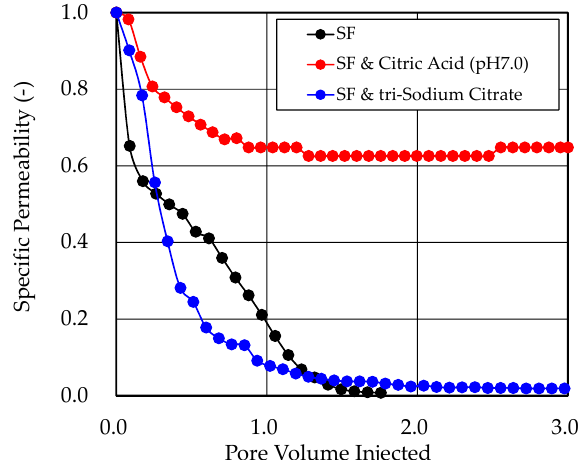
Figure 6. Temporal change in the specific permeability during the injection of the testing solutions.